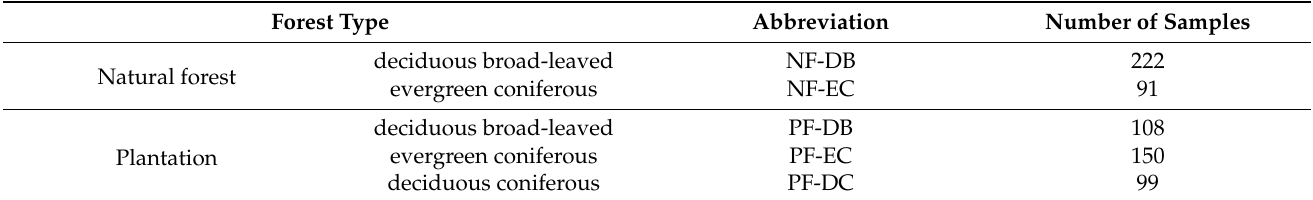
Table 1. The number of